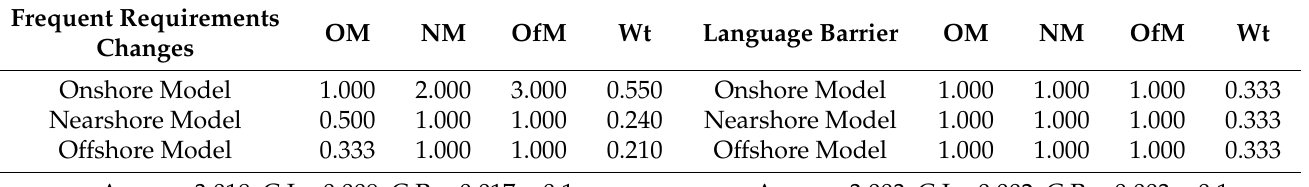
Table A5. Case study-2: Calculation of alternative preferences with respect to frequent requirement changes and language barrier.